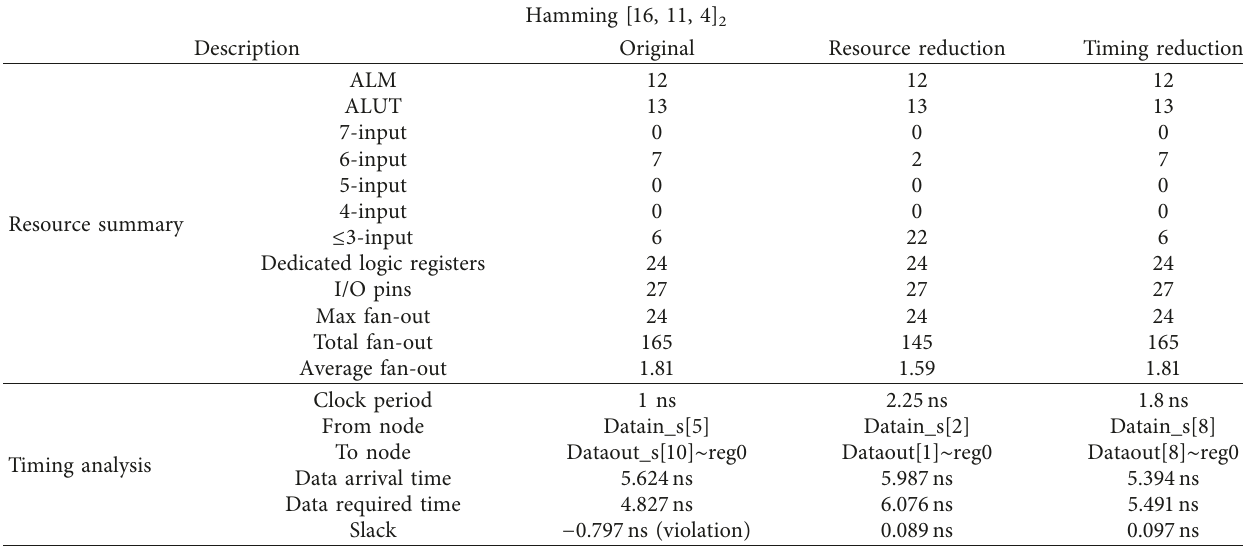
Table 10: Original vs optimized Hamming